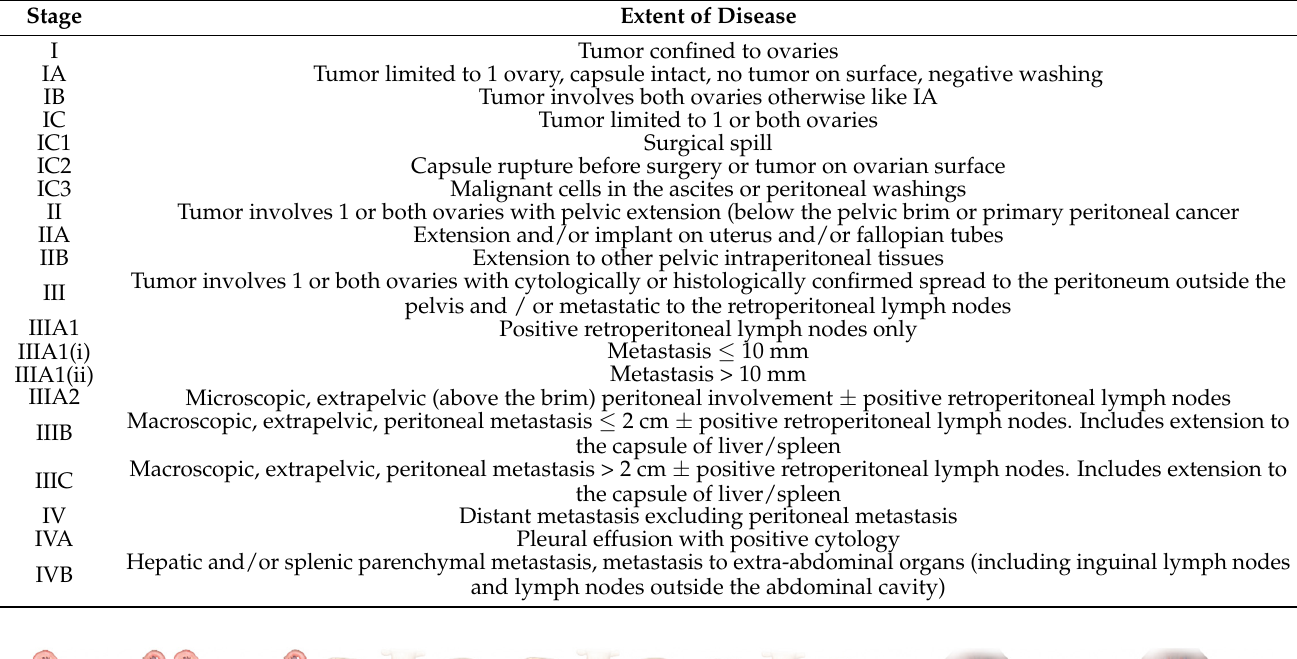
Table 9. The International Federation of Gynecology and Obstetrics (FIGO) staging of ovarian can- cer (2014).